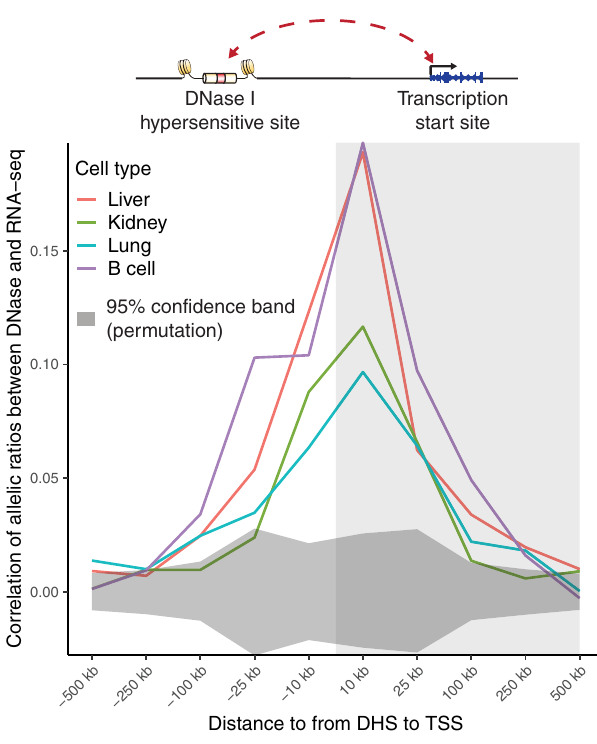
Fig. 7 Imbalanced accessibility and transcript levels. Pearson correlation in allelic ratios between SNVs in DHSs and transcript levels are broken down by distance to the transcription start site (TSS). All pairs of DHSs and TSSs within 500 kb are considered. Dark gray shading at the bottom indicates a 95% con fi dence band from 1000 permutations of DHS allelic ratios among DHS-TSS pairs for each cell or tissue type. Light gray shading at right indicates that DHS lies downstream of